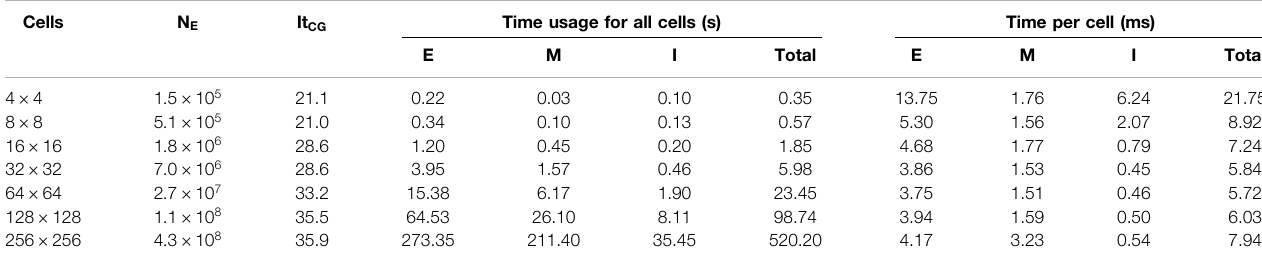
TABLE 6 | Time required to solve a time step of size Δ t (cid:2) 0 . 02 ms for geometries ranging from 4 × 4 cells to 256 × 256 cells using System A (see Section 4.4 ). Cells N E It CG Time usage for all cells